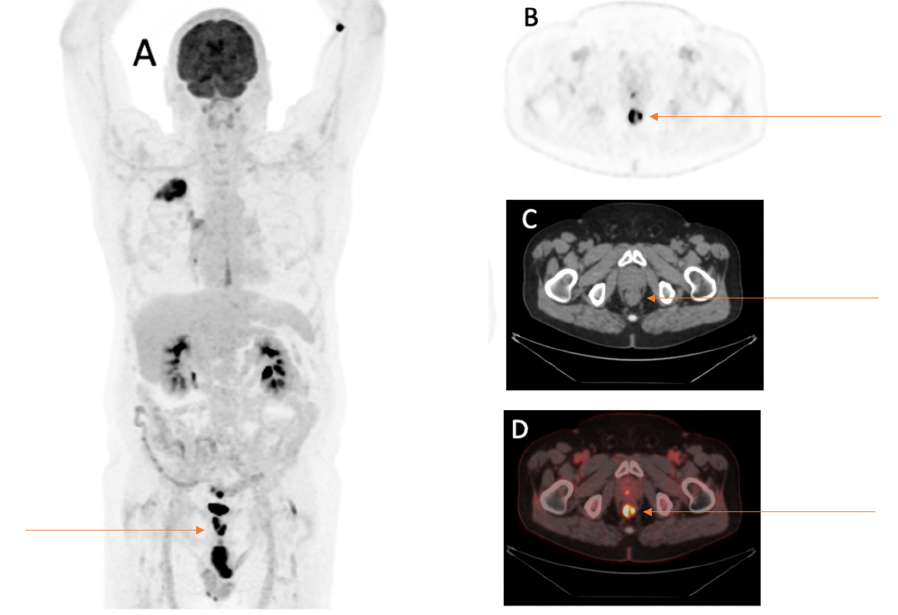
Figure 2. Sixty-nine-year-old male patient with first diagnosis of NSCLC (TTF1 positive adenocarci- noma of the right lower lobe pT2a, pN0, M0) underwent FDG-PET/CT for staging. FDG-PET/CT scan displayed an incidental FDG-avid wall thickening of the rectum. ( A ) MIP image after the intravenous injection of 245 MBq 18 F-FDG. ( B ) PET image of the rectum. ( C ) CT image of the rectum. ( D ) Fused PET/CT image of the rectum. After further investigations following the FDG-PET/CT, the wall thickening was histopathologically confirmed as microsatellite stable adenocarcinoma of the rectum T3 cN2 cM0, 5 cm oral to the anus.